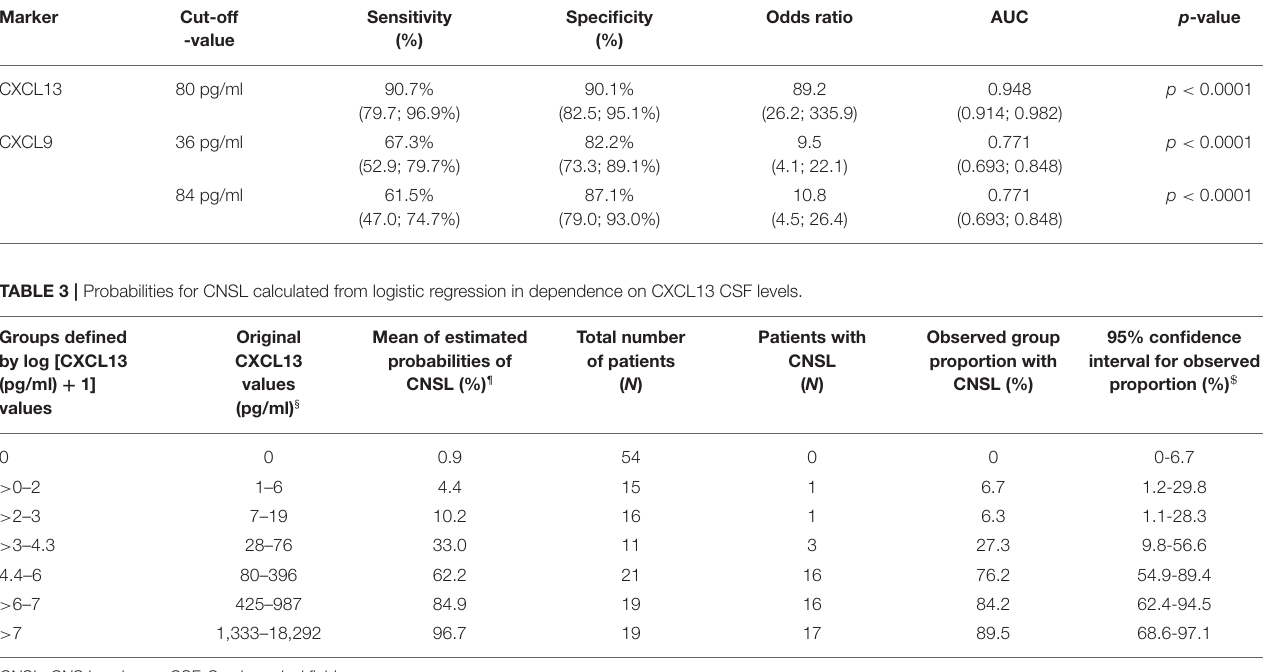
TABLE 2 | Sensitivity, specificity and odds ratio for CXCL13 and CXCL9 in CNSL. Marker